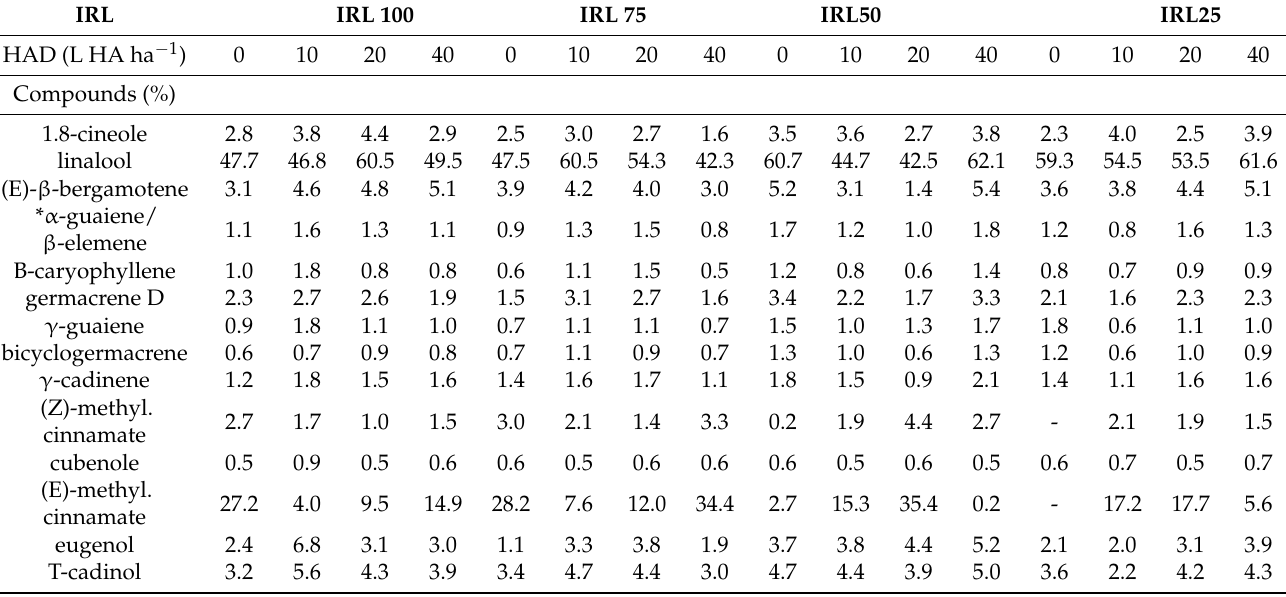
Table 8. Essential oil components of O. basilicum L. according to different IRLs and HADs under soil-mulching